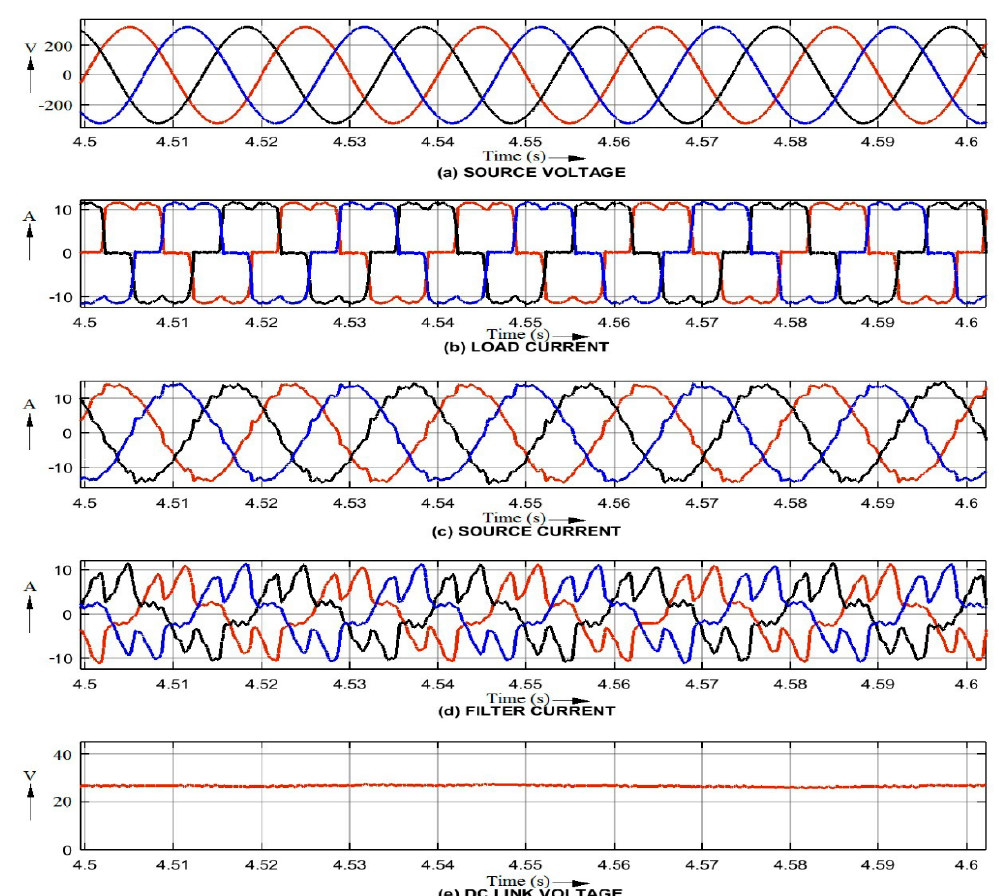
Figure 4. Performance of the compensator to the nonlinear load of current source type.